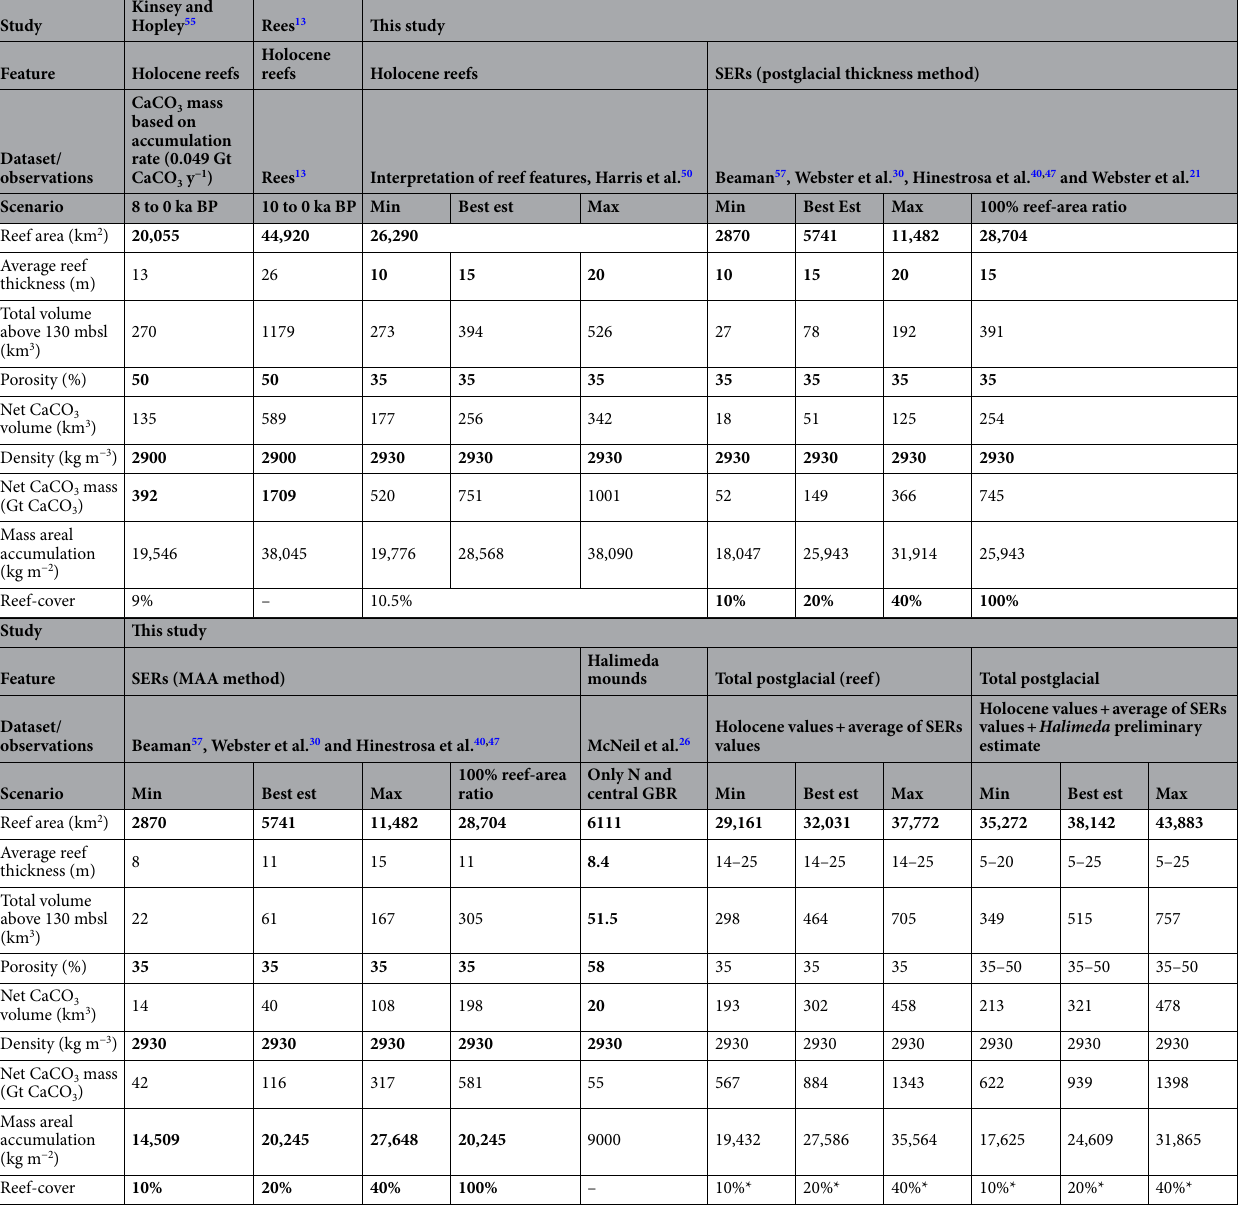
Table 1. GBR estimates of CaCO 3 volume, mass and MAA for the Holocene, shelf edge reefs and Halimeda bioherms of the GBR. Rees 13 and Kinsey and Hopley 55 estimates are shown for comparison. Bold highlight the parameters applied for calculation. *Values used for SERs